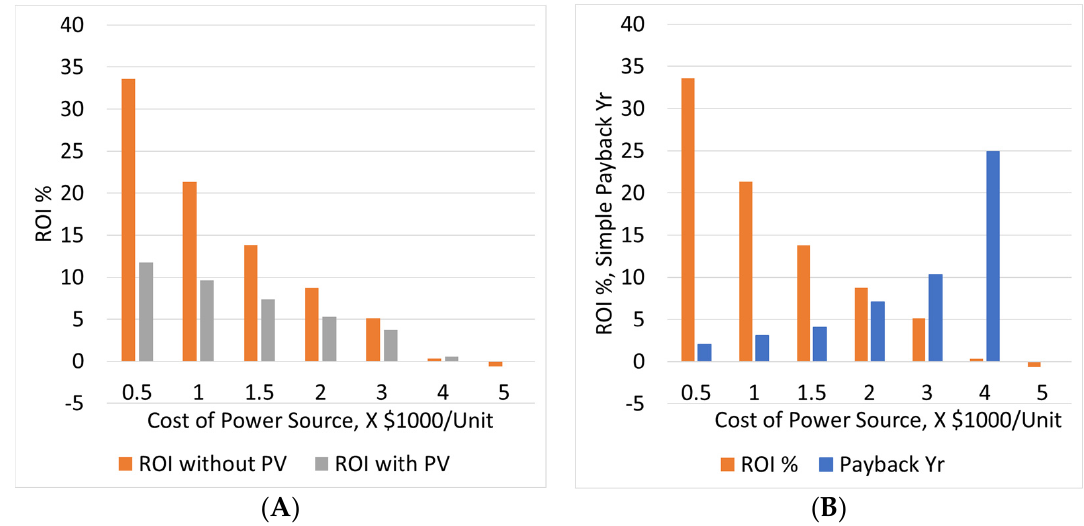
Figure 8. Economic analysis of the cogeneration system. ( A ) Influence of cost on ROI, with and without PV. ( B ) Payback period at different cogeneration system costs (no PV).